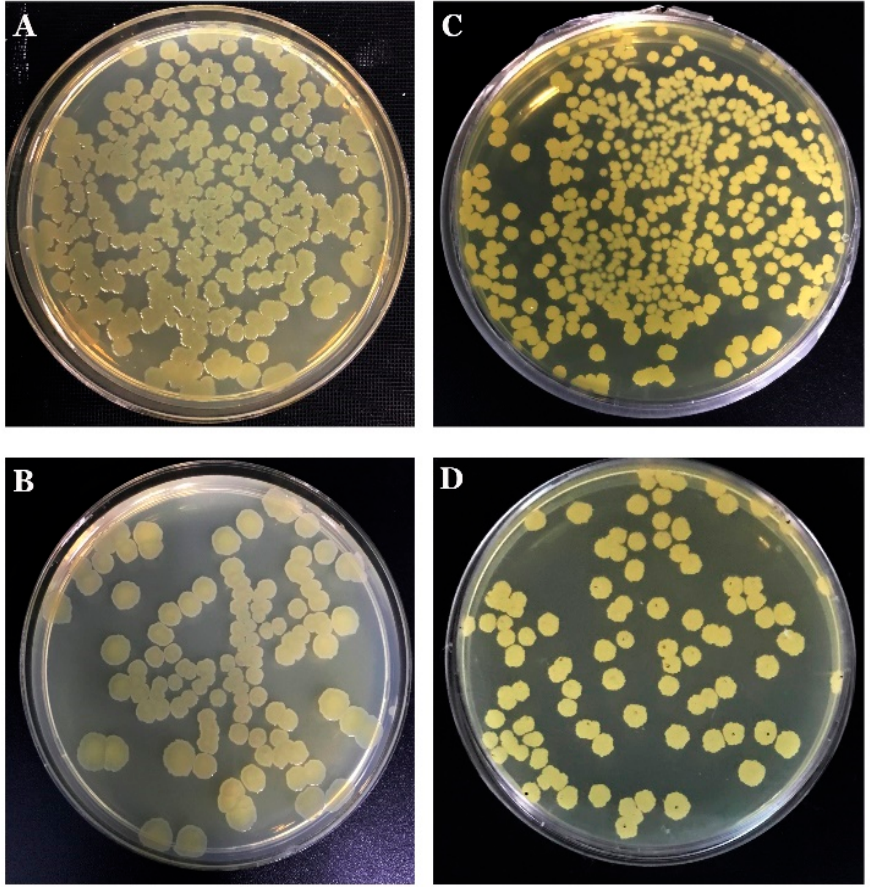
Figure 9. The endophytic ability of B. mojavensis P17 morphotypes I and II to colonize tomato plants. B. mojavensis P17(II) isolated from root ( A ) and shoot ( B ) surface-sterilized growth on LB medium. B. mojavensis PS17(I) isolated from root ( C ) and shoot ( D ) surface-sterilized growth on LB medium. 3.6. Plant Growth-Promoting Potential of B. mojavensis PS17